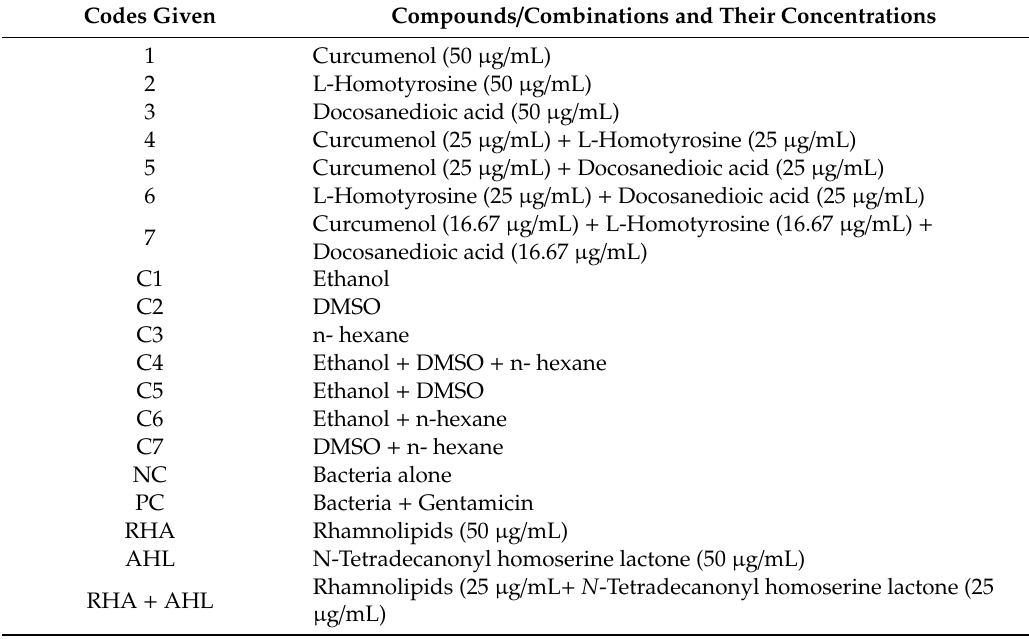
Table 2. Pure compounds identified from animal’s gut bacteria used in this study. Codes